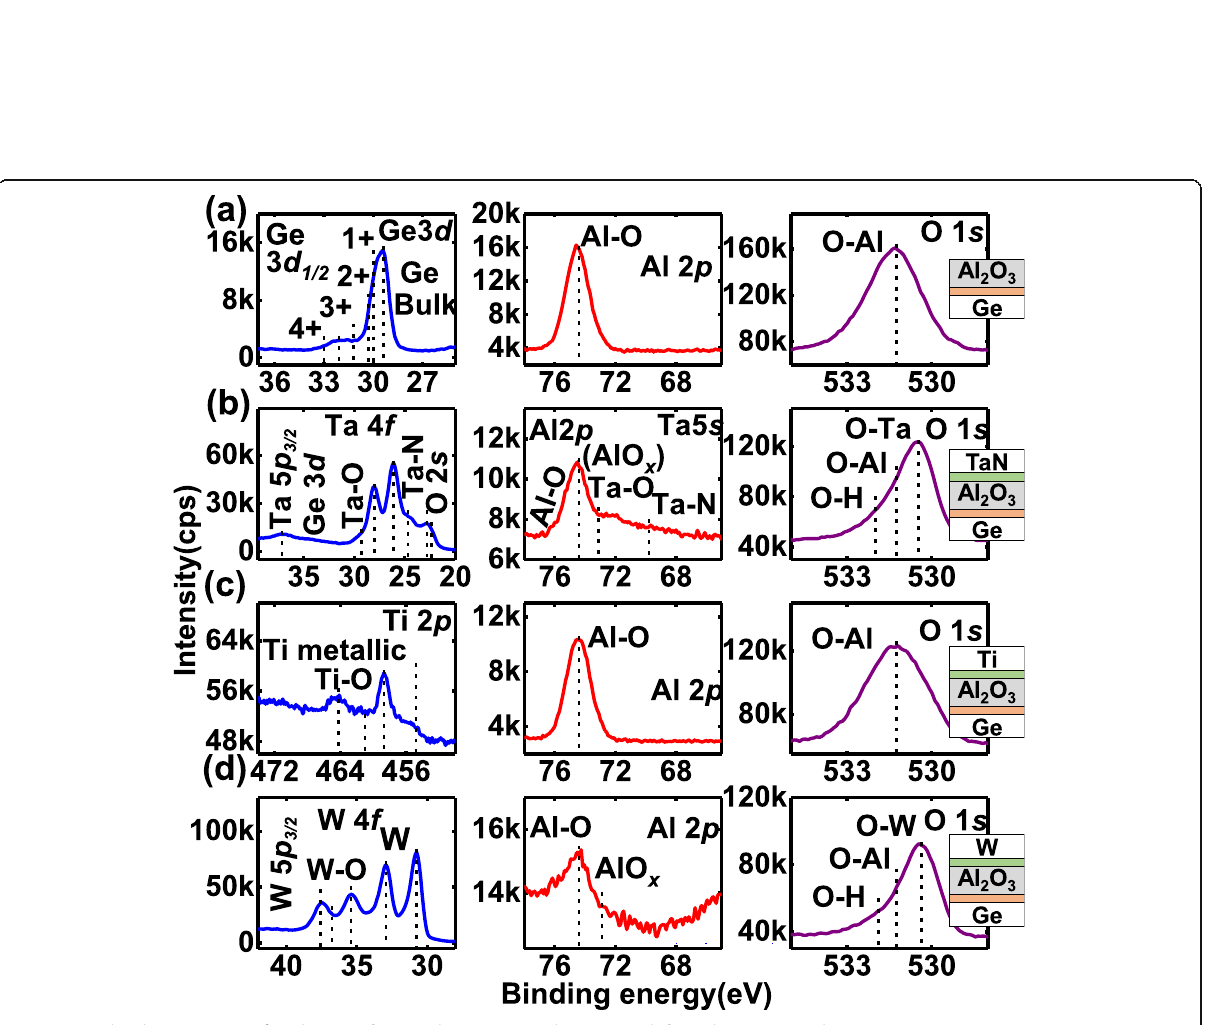
Fig. 4 Core level XPS spectra of a Al 2 O 3 /Ge, b TaN/Al 2 O 3 /Ge, c Ti/Al 2 O 3 /Ge, and d W/Al 2 O 3 /Ge